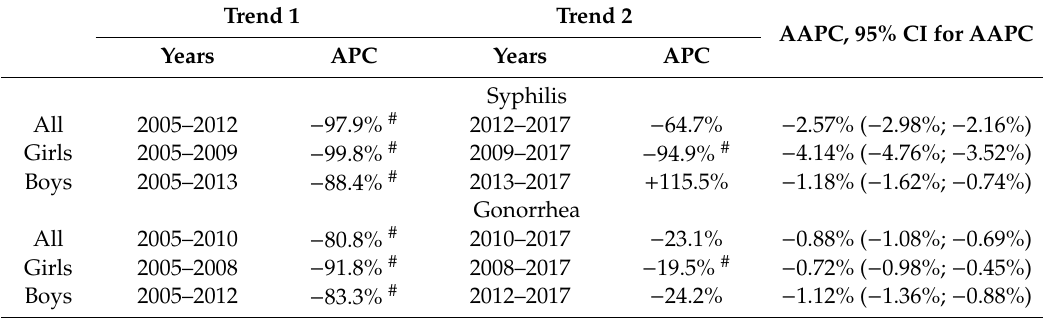
AAPC, 95% CI for AAPC